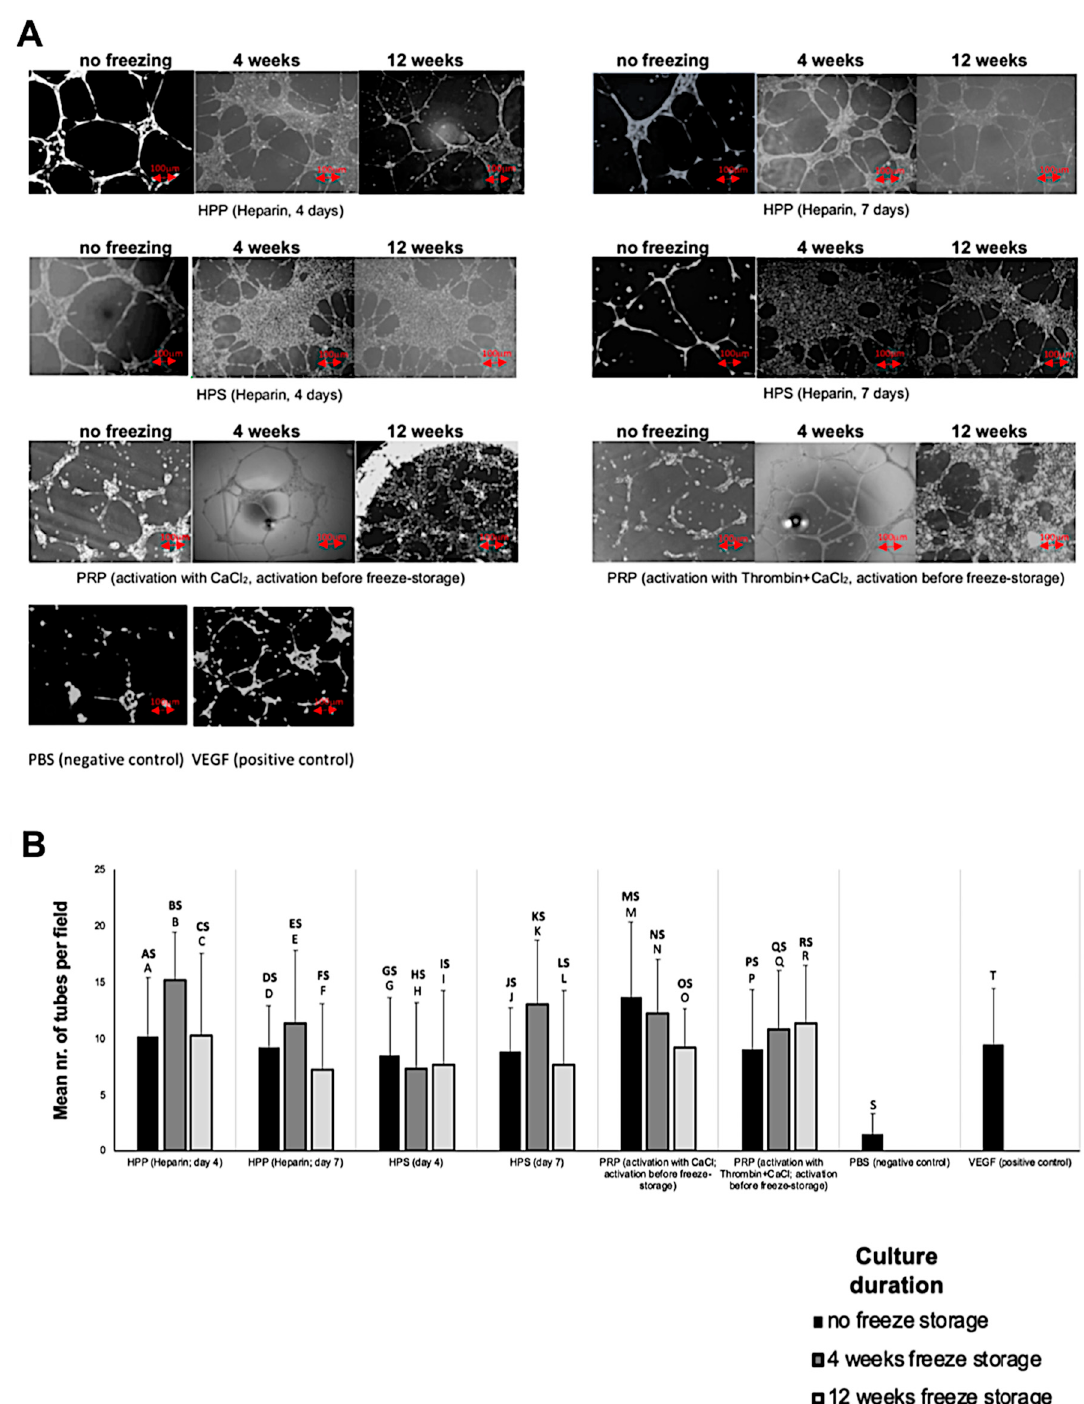
Figure 4. Effect of blood-derived secretome freeze-storage on angiogenic activity. ( A ) Panel showing representative images of the tube formation assay carried out with HPP, HPS and PRP secretomes that underwent freeze storage for 4 and 12 weeks (Bars = 100 μ m). ( B ) Plot comparing the mean number of tubes formed in endothelial cell cultures in the presence of fresh blood-derived secretomes or secretomes that underwent freeze-storage for 4 and 12 weeks at − 20 °C ( n = 5) ( p < 0.001). Capital letter pairs over plots indicate statistical comparison of corresponding data points. For all pair comparisons p < 0.05, unless otherwise indicated. Error bars represent s.d.